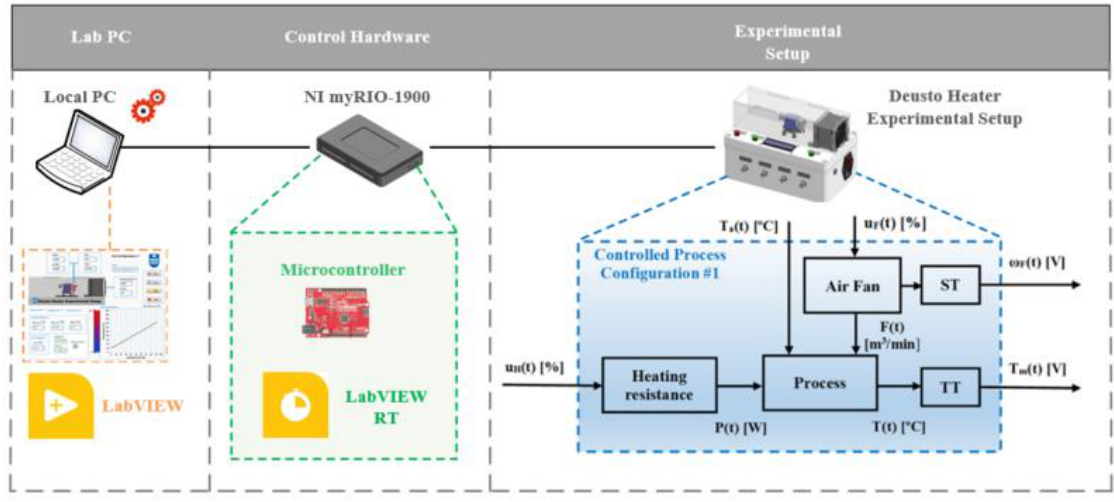
Figure 20. Scheme of microprocessor-based closed-loop implementation of temperature control with Controlled Process Configuration #1.